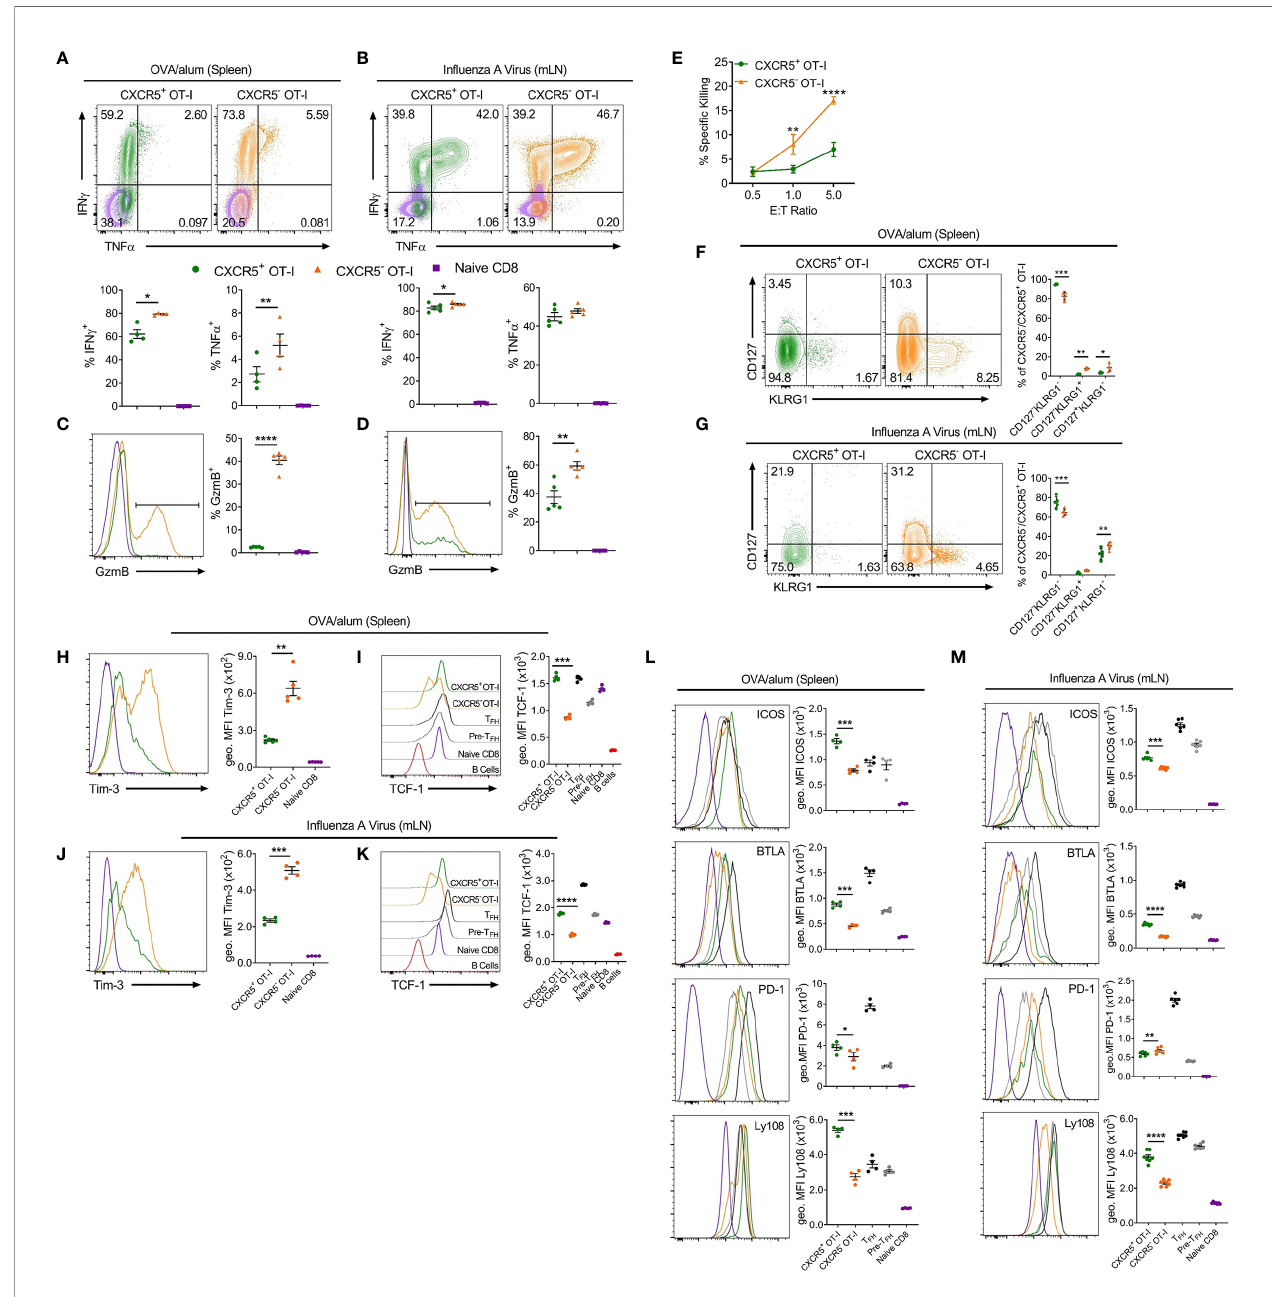
FIGURE 2 | CXCR5 + CD8 + T cells generated in response to OVA/alum and IAV are distinct from their CXCR5 - counterparts. Isolated congenically marked (CD45.1/ 2) OT-I cells were transferred i.v into C57BL/6 mice that were immunised with OVA/alum i.p or infected with x31-OVA i.n the following day. On day 7 post- immunisation and day 8 post-infection, the spleens (OVA/alum) and mLNs (x31-OVA) were harvested and analysed by fl ow cytometry. (A, B) IFN g and TNF a expression by CXCR5 + and CXCR5 - OT-I cells and naïve CD8 + T cells following (A) OVA/alum and (B) x31-OVA. (C, D) Granzyme B (GzmB) expression by CXCR5 + and CXCR5 - OT-I cells and naïve CD8 + T cells following (C) OVA/alum and (D) x31-OVA. (E) Ex vivo cytotoxicity assay assessing the speci fi c killing of CXCR5 + and CXCR5 - OT-I cells FACS-sorted from the spleens of mice immunised i.p with OVA/alum 7 days prior. (F, G) CD127 and KLRG1 expression by CXCR5 + and CXCR5 - OT-I cells following (F) OVA/alum and (G) x31-OVA. (H, J) Tim-3 expression by CXCR5 + and CXCR5 - OT-I cells and naïve CD8 + T cells following (H) OVA/alum and (J) x31-OVA. (I, K) TCF-1 expression by CXCR5 + and CXCR5 - OT-I cells, TFH, Pre-TFH, Naïve CD8 + T cells and B220 + B cells following (I) OVA/alum and (K)